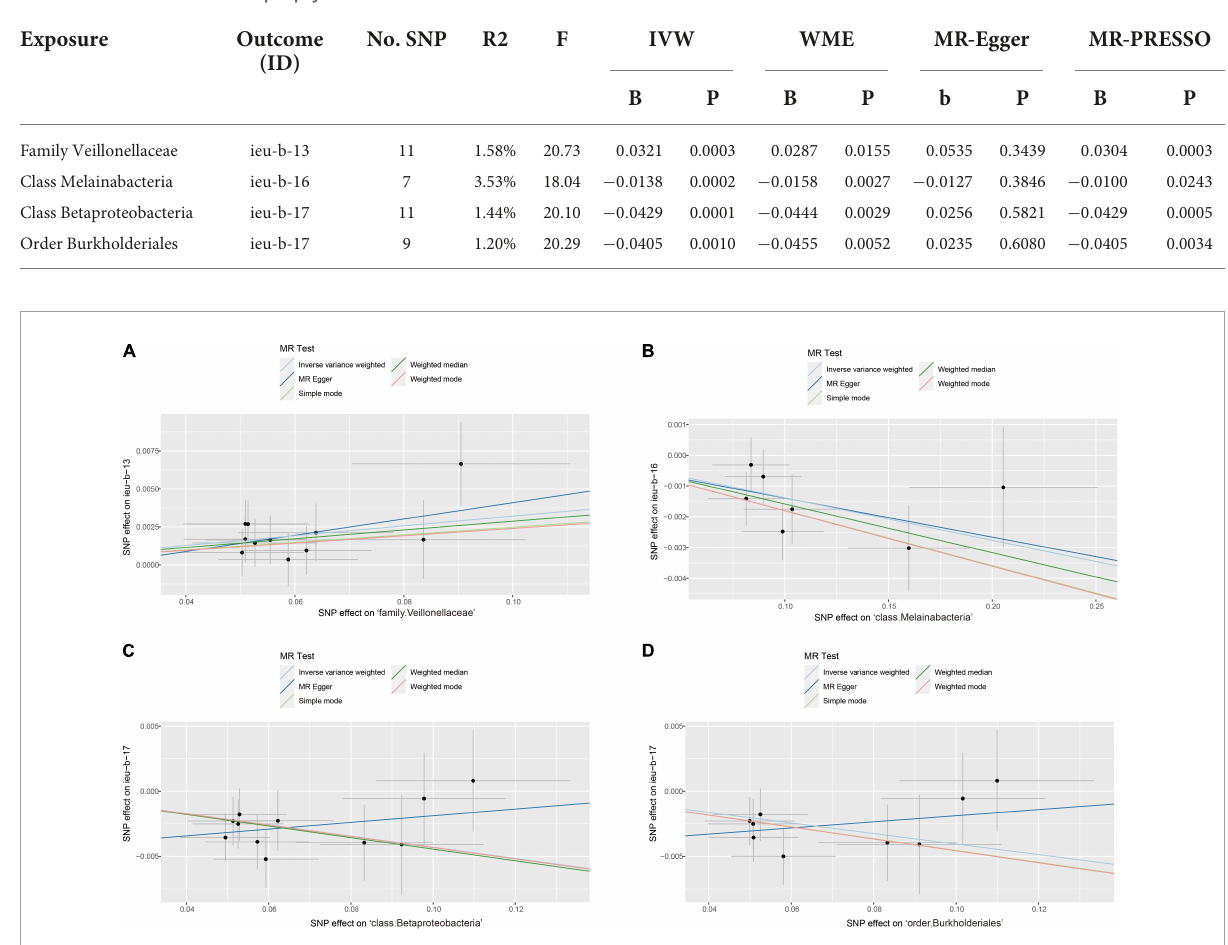
FIGURE2 Scatter plots of significant causality of the gut microbiota and epilepsy. (A) Scatter plots of the family Veillonellaceae on childhood absence epilepsy. (B) Scatter plots of the class Melainabacteria on generalized epilepsy with tonic-clonic seizures. (C) Scatter plots of the class Betaproteobacteria and (D) The order Burkholderiales on juvenile myoclonic epilepsy. The lines move obliquely upward from left to right exhibiting a positive correlation between the gut microbiota and epilepsy with horizontal and vertical lines indicating the 95% confidence interval of each association. The lines with a negative correlation are inclined downward from left to right, indicating a protective effect of the gut microbiota on